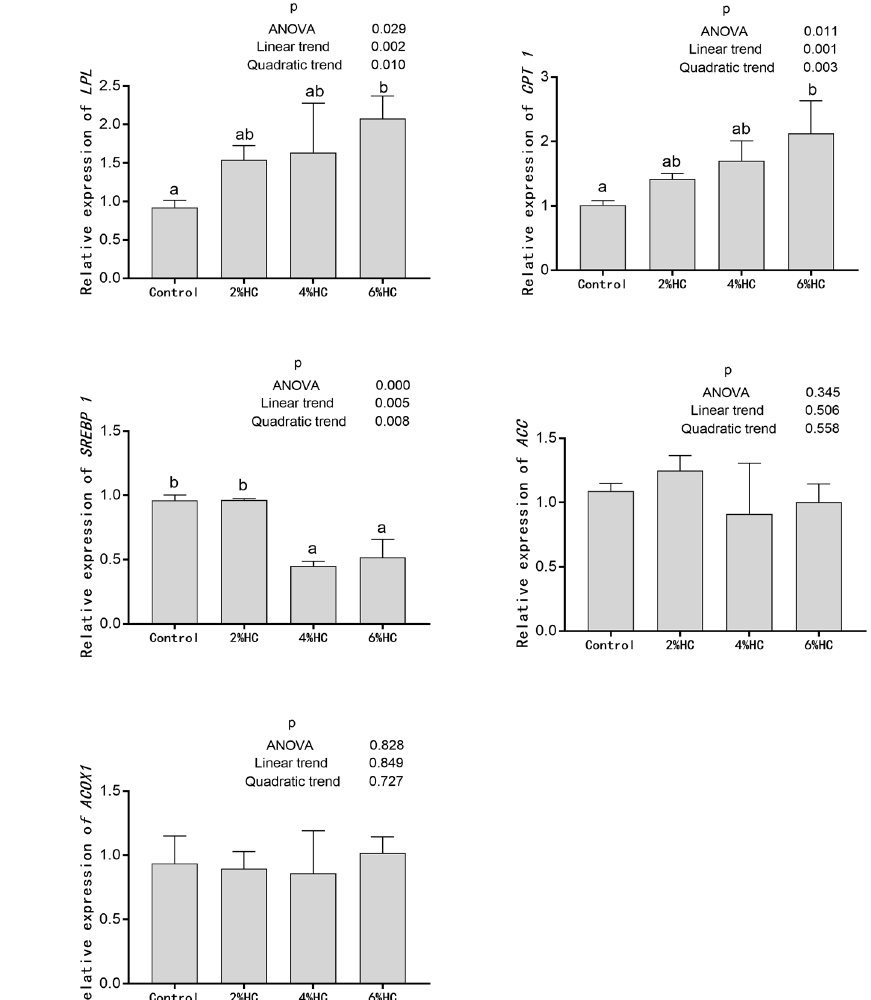
Figure 3. Effects of hydrolyzed collagen replacing fish meal on the expression levels of genes related to lipid metabolism in liver of triploid crucian carp. Values are presented as mean ± SE ( n = 3). Different letters indicate significant differences ( p < 0.05) .